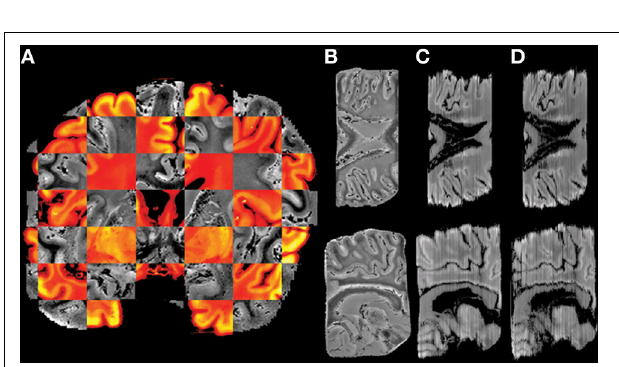
FIGURE 5 | Example of histology reconstruction of HB1. (A) Checker-board view of affine registered MR slice (gray) and histological section (color) showing good cross-modality alignment in the fine structures. The axial and sagittal views of the images are shown in the top and bottom row, respectively. (B) MR volume in histological space after 3D affine registration, (C) Histological volume reconstructed by section-to-section 2D affine registration, and (D) Histological volume created by stacking the non-linearly registered histological sections to the corresponding MR